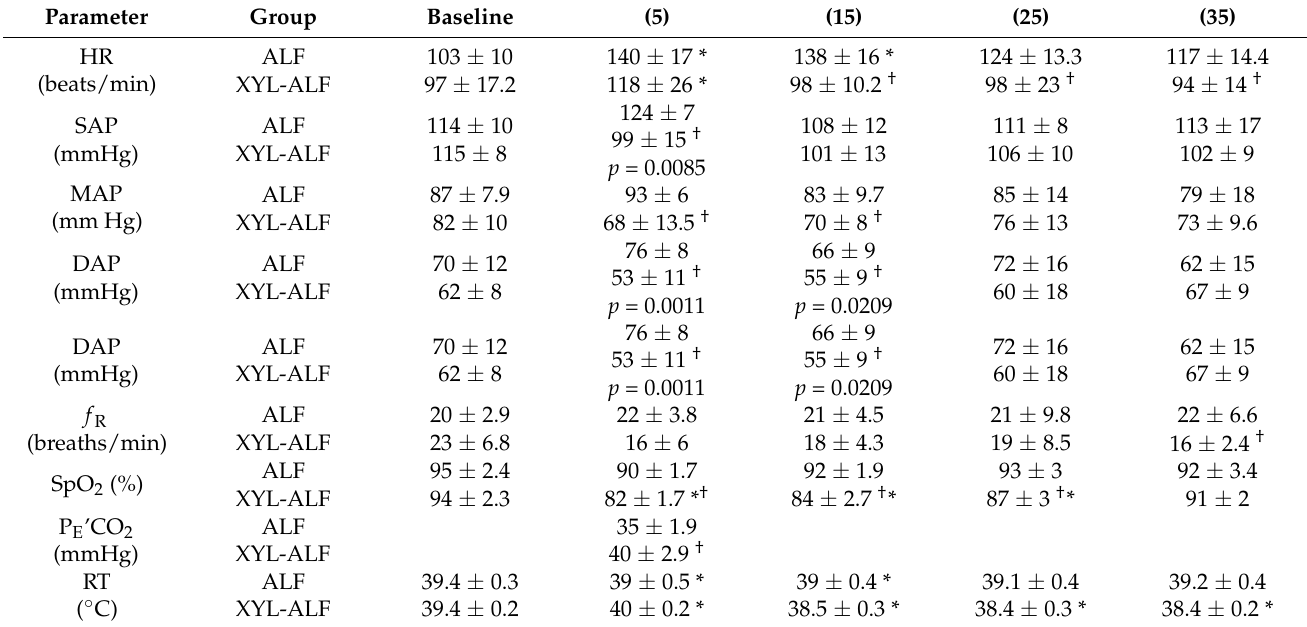
Table 2. Cardiorespiratory variables and rectal temperature measured in goats at baseline and at 5, 15, 25 and 35 min after alfaxalone administration in the ALF group (4.0 ± 0.30 mg/kg bw; IV) (n = 6) and the XYL-ALF group (2.3 ± 0.25 mg/kg bw; IV) (n = 6).